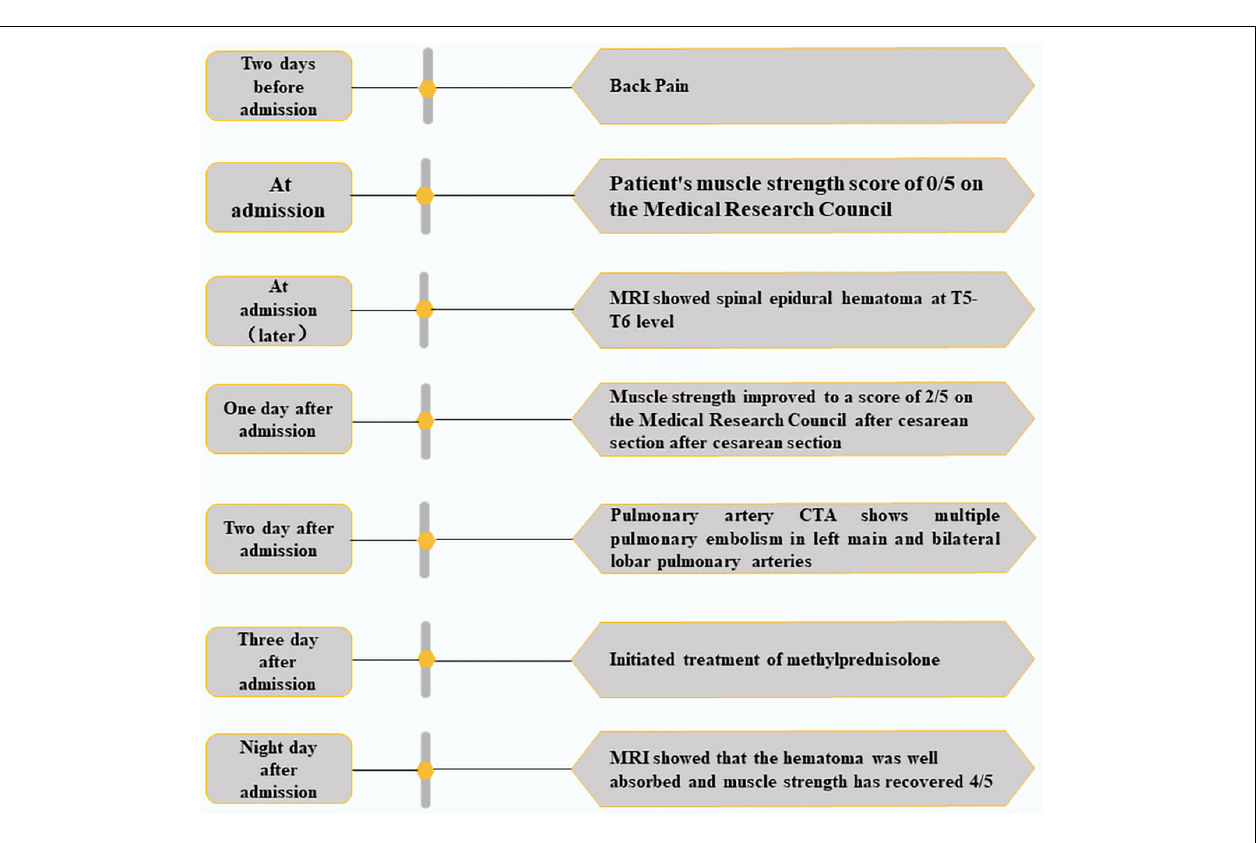
FIGURE 4 | Timeline of historical and current information from this